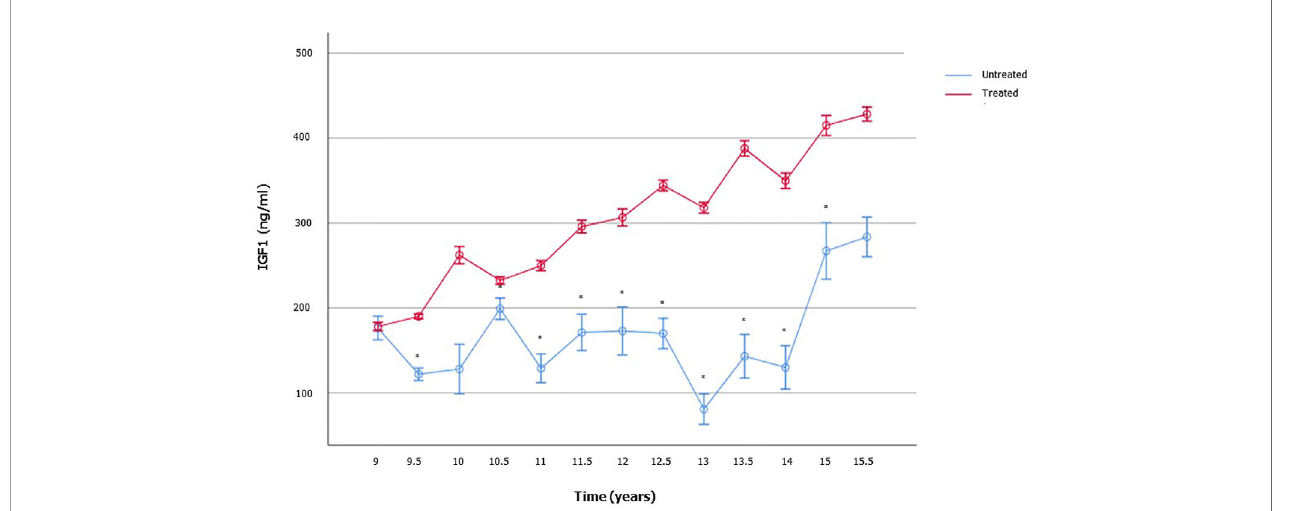
FIGURE 4 | Insulin-like growth factor 1 (IGF1) serum levels in boys with growth hormone (GH) de fi ciency who received recombinant human GH (rhGH) and in aged- matched not yet treated GHD boys. The number of patients available for each time point is reported in the Supplementary Table 2